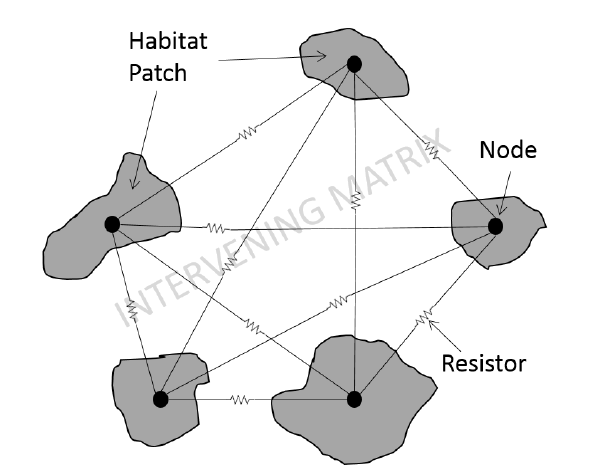
Figure 1. Terms and concepts in Circuit Theory (Adapted from Minor and Urban, 2007).